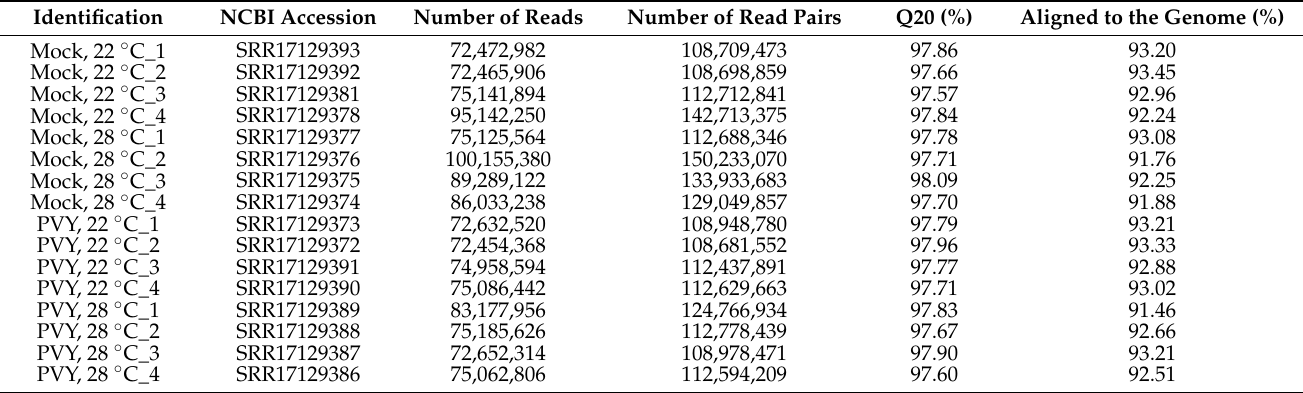
Figure 1. Overview of sequencing data. ( A ) Schematic representation of the experimental setup. ( B ) Principal Component Analysis (PCA) based on short-read sequencing. ( C ) Principal Component Analysis (PCA) based on long-read sequencing. ( D ) Prediction of lncRNA using 4 different models, CNIT (Coding-Non-Coding Identifying Tool), PLEK (Predictor of Long non-coding RNAs and mEssenger RNAs based on an improved K-mer scheme), CPC2 (Coding Potential Calculator) and LGC (ORF Length and GC content). ( E ) Expression of mRNAs vs. lncRNAs. FPKM, Fragments Per Kilobase of transcript per Million mapped reads. Table 1. Short reads sequencing